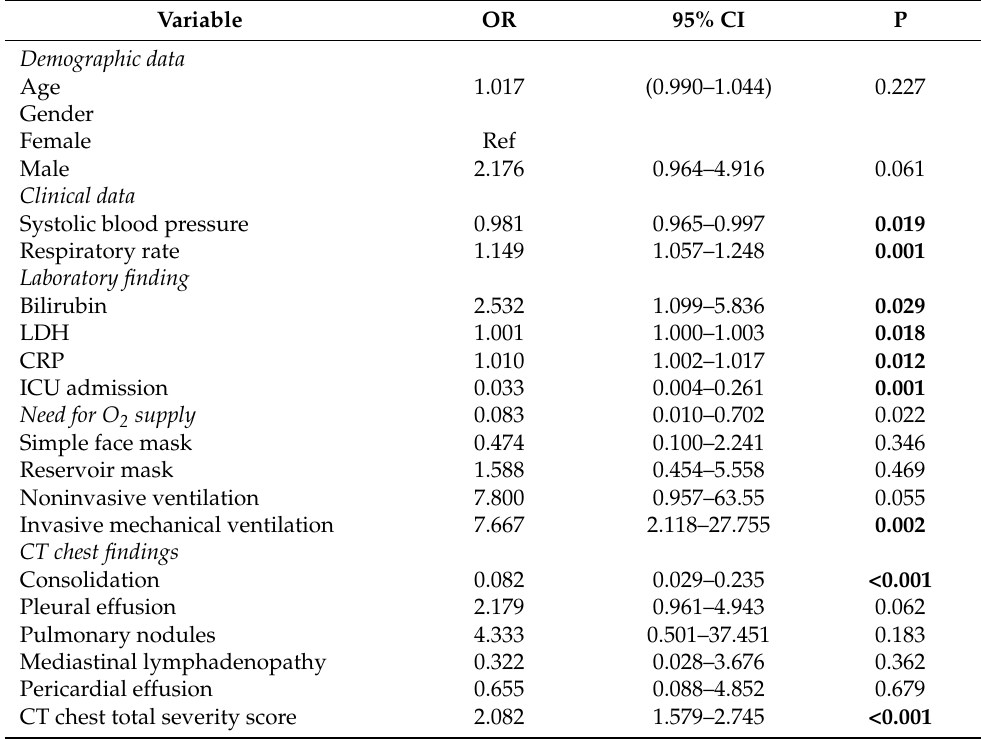
Table 3. Univariate logistic regression analysis of factors associated with mortality.